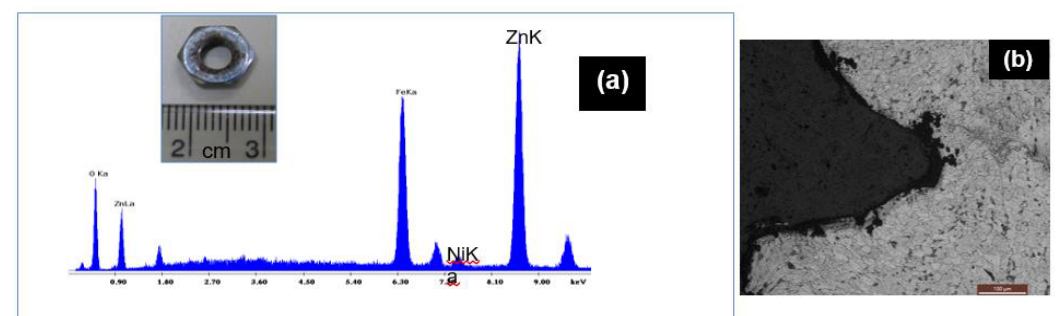
Figure 10: (a) EDS analysis result for the corrosion product sitting on the surface of nut (inset: as-received photograph showing the corrosion of nut) (b) etched optical micrograph along the threaded region showing moderate degree of pitting.